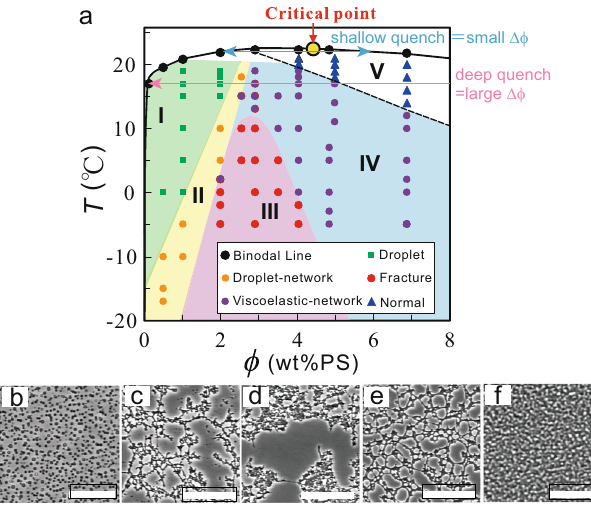
Fig. 1 State diagram and typical phase-separation patterns observed in a polystyrene/diethyl malonate mixture. a State diagram, in which we show what type of phase separation is observed at each state point. The weight- averaged molecular weight of polystyrene was M w ¼ 7 : 04 ´ 10 5 . ϕ is the concentration of polystyrene, and T is the temperature. Phase separation is induced by quenching the temperature from the one-phase region to a state point (see the symbols) in the two-phase region. The mixtures were sandwiched between two cover glasses, whose gap was set to 5 μ m. A shallow/deep quench leads to a small/large difference in ϕ between the two phases, Δ ϕ (see the blue/pink arrow), resulting in weak/strong dynamic asymmetry. The phase separation (PS) can be grouped into fi ve types. (I): metastable-droplet PS; (II): droplet-network PS; (III): fracture PS; (IV): network PS; (V): normal PS. The dashed black line denotes the border between viscoelastic phase separation (VPS) and normal phase separation, i.e. the border between regions IV and V. b Typical phase separation pattern in region I. The scale bar corresponds to 50 μ m. c Typical phase separation pattern in region II. The scale bar corresponds to 100 μ m. d Typical phase separation pattern in region III. The scale bar corresponds to 400 μ m. e Typical phase separation pattern in region IV. The scale bar corresponds to 200 μ m. f Typical phase separation pattern in region V. The scale bar corresponds to 50 μ